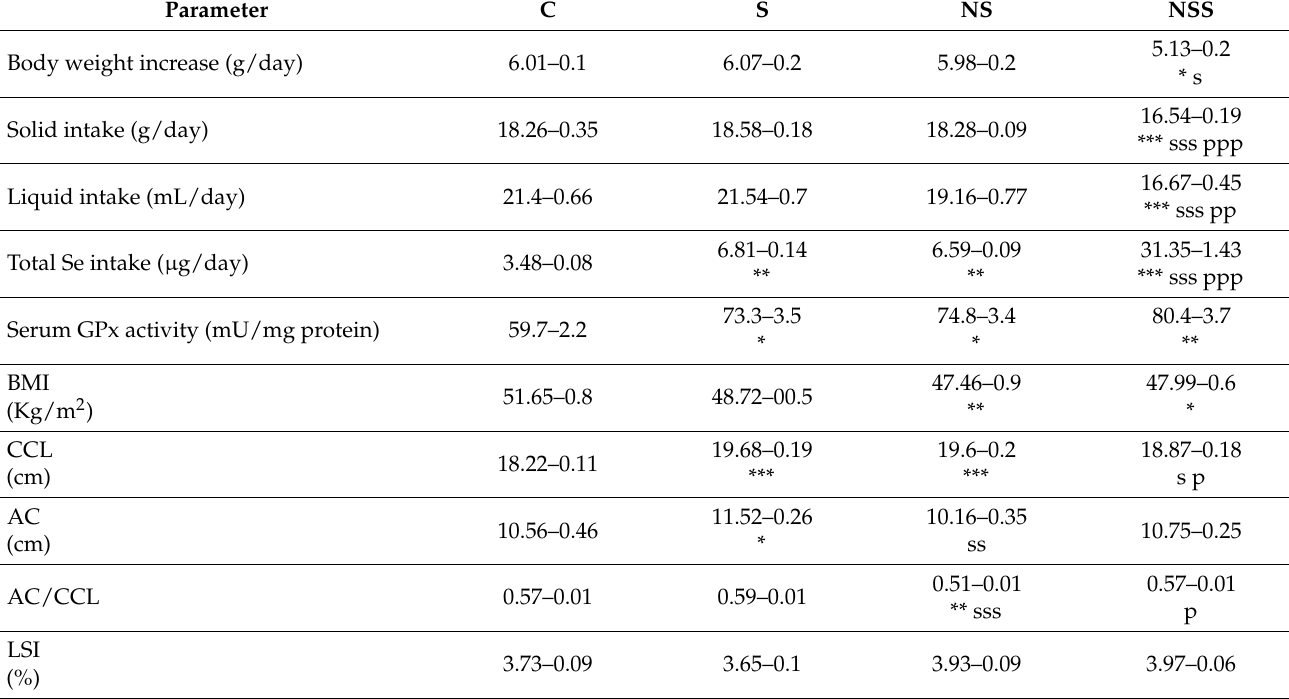
Table 1. Nutritional and anthropomorphic parameters at the end of the experimental